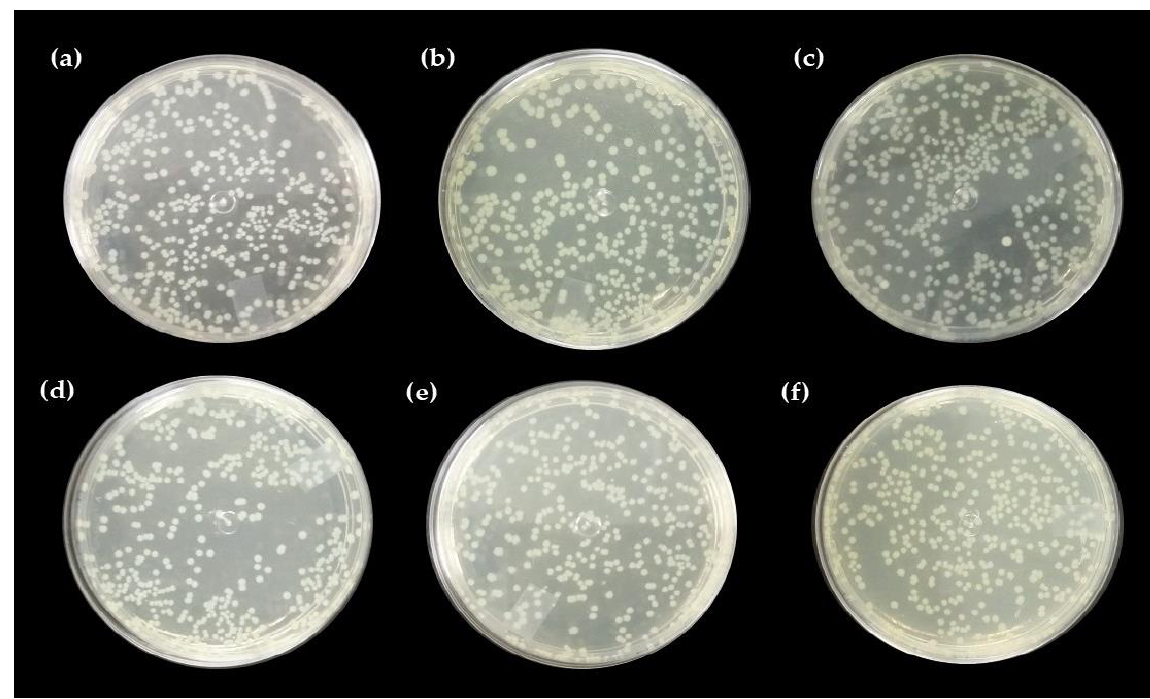
Figure 5. Direct contact test for ( a ) control, ( b ) N1, ( c ) N2, ( d ) GChi, ( e ) GChiN1, and ( f ) GChiN2 against Staphylococcus aureus (ATCC 25,923).